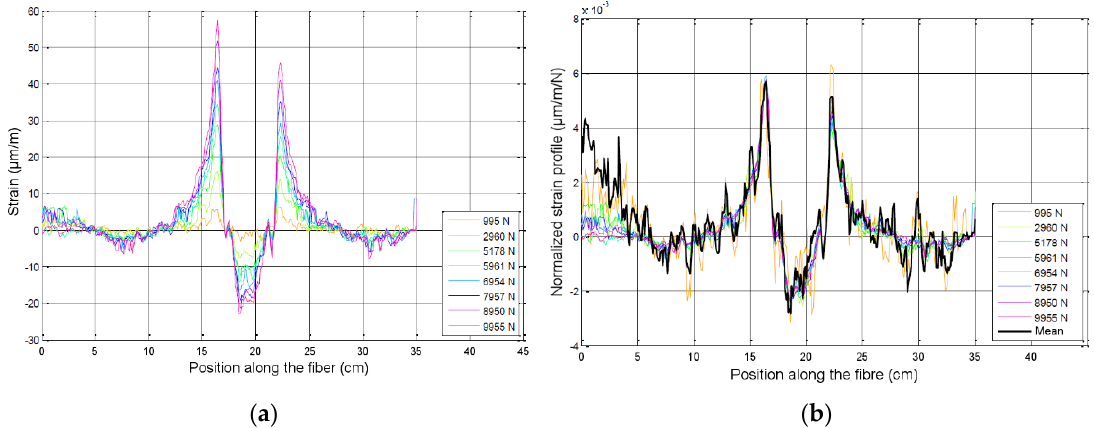
Figure 11. ( a ) DOFS strain profiles at increasing load levels for the joint of Adhesive 1; ( b ) normalized strain profiles.